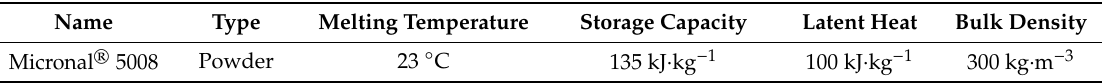
Table 4. Micronal ® 5008, microencapsulated phase change material (mPCM) properties